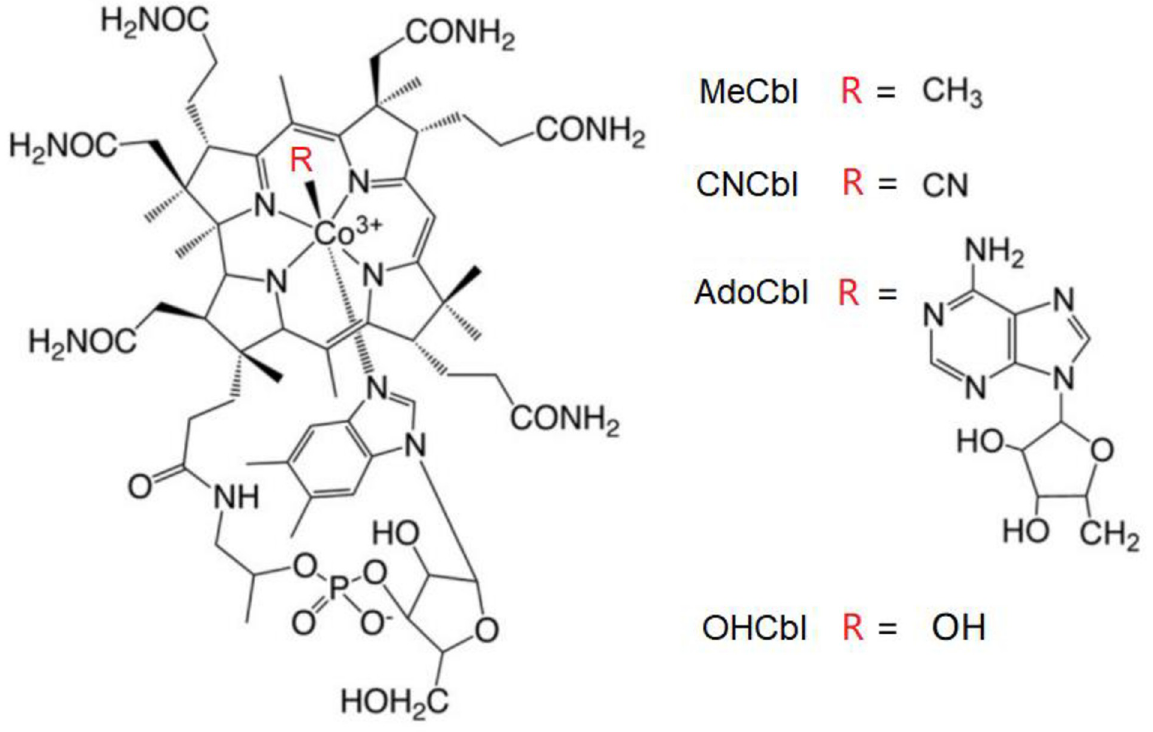
Fig 1. Chemical structures of four cobalamins. R group may be: OH (hydroxycobalamin, OHCbl), CN (cyanocobalamin, CNCbl), 5’- deoxyadenosyl (adenosylcobalamin, AdoCbl) and CH3 (methylcobalamin, MeCbl).